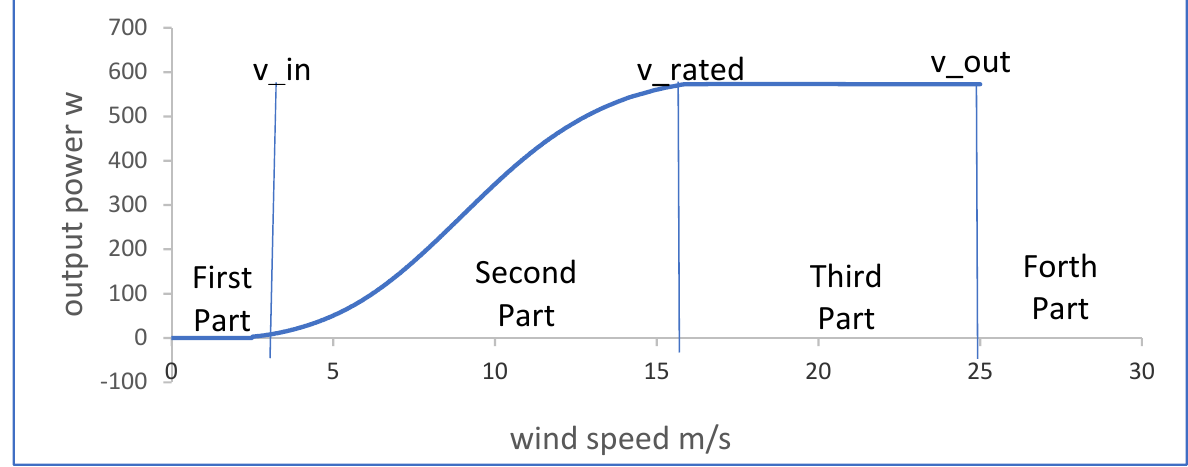
Figure 8. Typical wind turbine power curve.